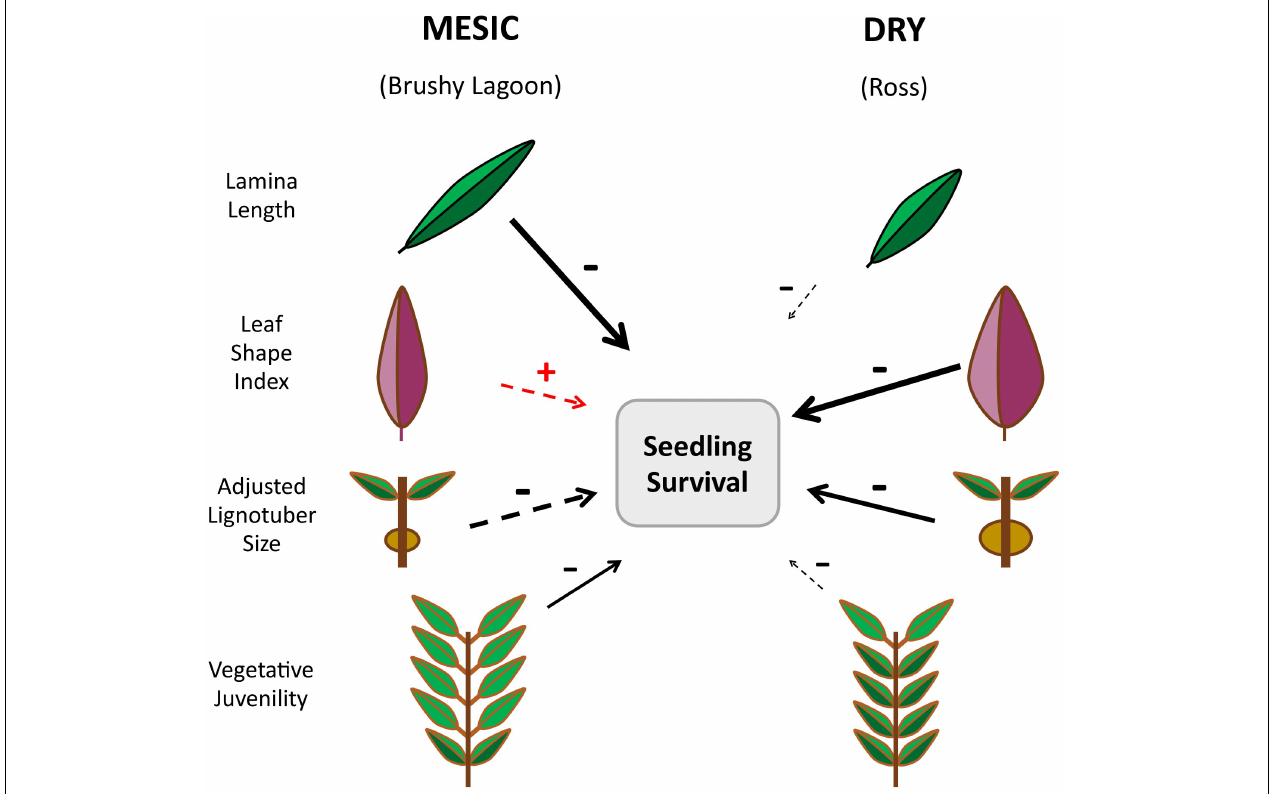
FIGURE 1 | Infographic summarizing the differences between the mesic (Brushy Lagoon) and dry (Ross) populations of Eucalyptus pauciflora for the least-squares means and directional selection gradients estimated for four seedling functional traits. Population-mean differences were statistically significantly ( p < 0.01) for all focal traits assessed ( Table 2 ). The directional selection gradient estimates for each population are symbolized by the arrows, which refer to the partial linear effect of a focal trait on seedling canopy (relative) survival evaluated after 67 days of dry-down. The increasing length and width of the arrows is indicative of increasing strength of the directional selection gradient estimates, and their directionality is shown by the +/ − signs. In addition, a solid arrow indicates that the bootstrapped 95% confidence interval (CI) for the selection gradient estimate did not overlap with zero, providing statistical support against the null hypothesis of no effect on relative seedling survival ( Table 5 ). A dashed arrow signifies that the bootstrapped 95% CI for the selection gradient estimate overlapped with zero, being indicative of no statistical support for the existence of fitness consequences of variation in the trait. The strong negative selection gradient estimated for lamina length in the mesic population suggests that a future occurrence of severe drought in the wild will shift the mean of the trait in the mesic population toward that of the dry population. The negative selection gradient estimated for adjusted lignotuber size in both populations suggests an early age trade-off between drought damage and recovery traits, with the canopies of phenotypes which develop larger lignotubers at the seedling stage being more susceptible to drought